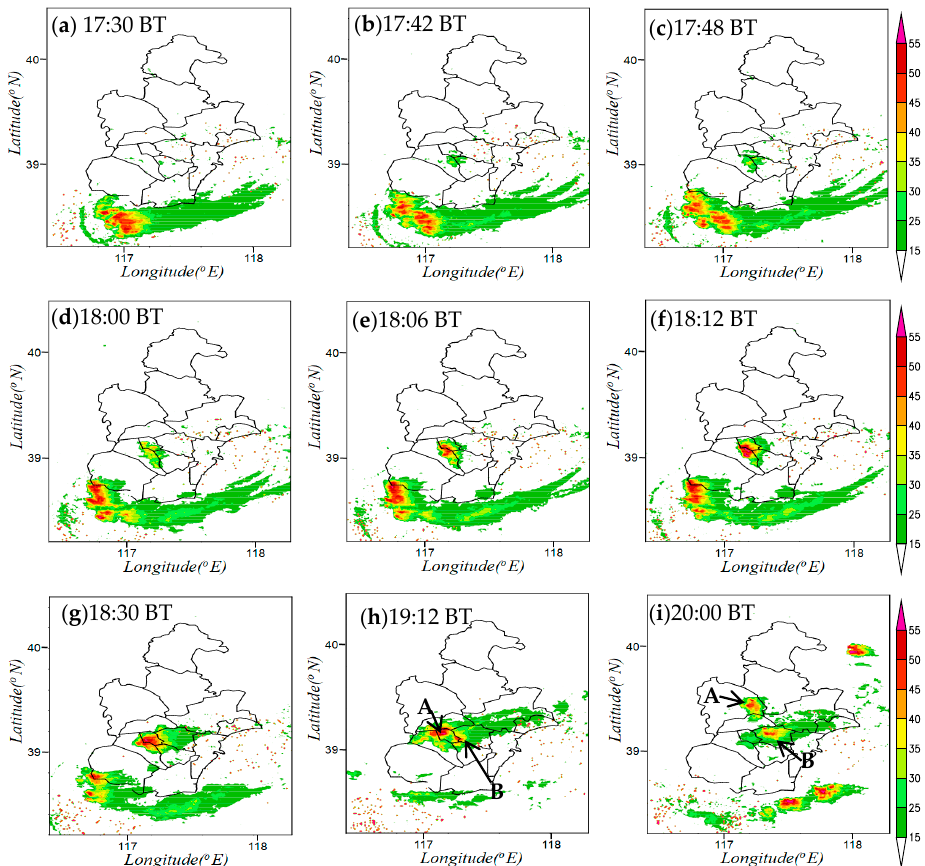
Figure 3. Composite reflectivity (colored, unit: dBZ) from the S-band Radar of Tanggu in Tianjin: ( a ) 17:30; ( b ) 17:42; ( c ) 17:48; ( d ) 18:00; ( e ) 18:06; ( f ) 18:12; ( g ) 18:30; ( h ) 19:12; ( i ) 20:00 BT. “A” and “B” represent the position of two